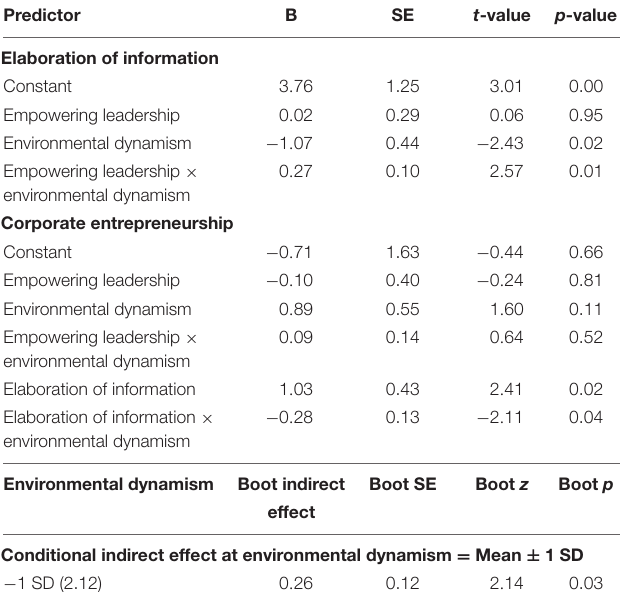
TABLE 4 | Regression results for conditional indirect effect.